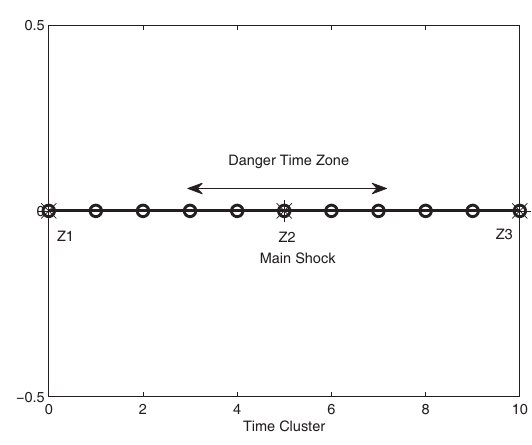
Fig. 4. Example of time zone clustering